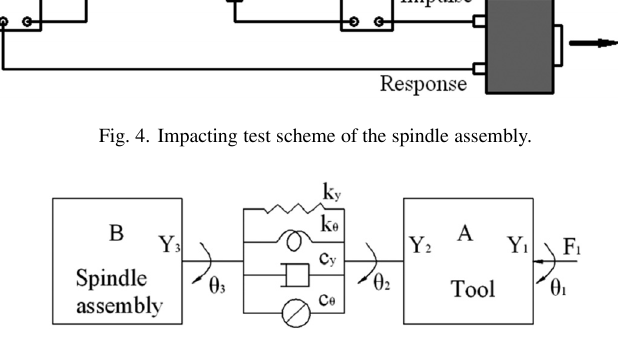
Fig. 5. Coupling model of the spindle-holder-tool